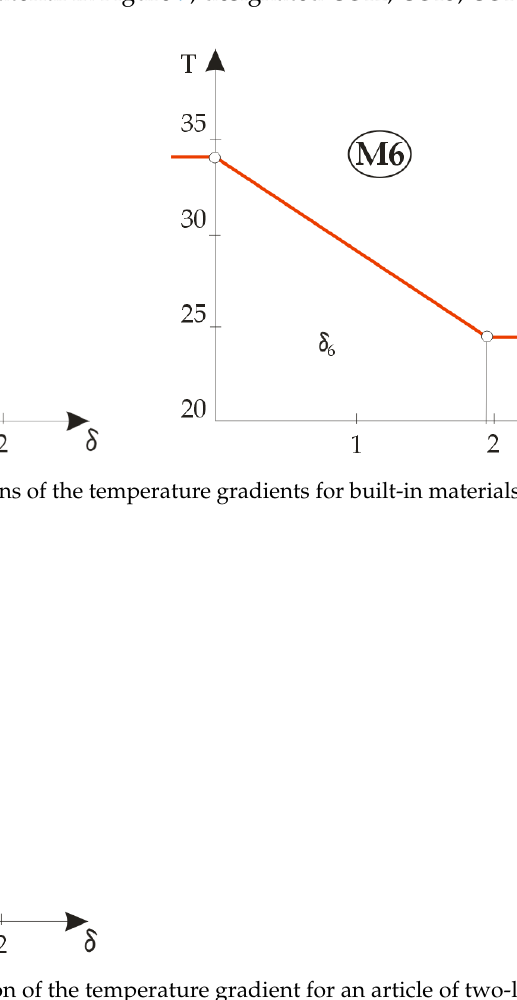
Figure 8. Graphical representation of the temperature gradient for an article of two-layer composite clothing.